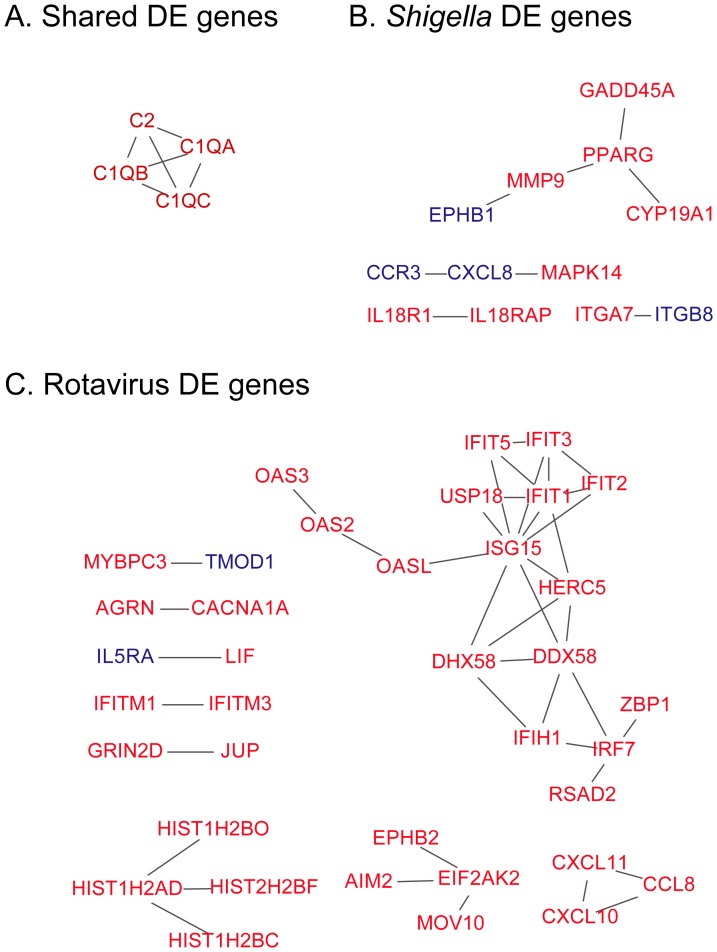
Differentially expressed genes in Shigella and rotavirus infections form protein-protein interaction networks.Nodes represent genes and edges represent interactions. Red nodes represent genes with increased expression relative to controls and blue nodes represent genes with decreased expression. (A-C) Shown is the network of genes differentially expressed shared by the Salmonella, Shigella, and rotavirus groups (A), genes unique to the Shigella group (B), and unique to the rotavirus group (C).